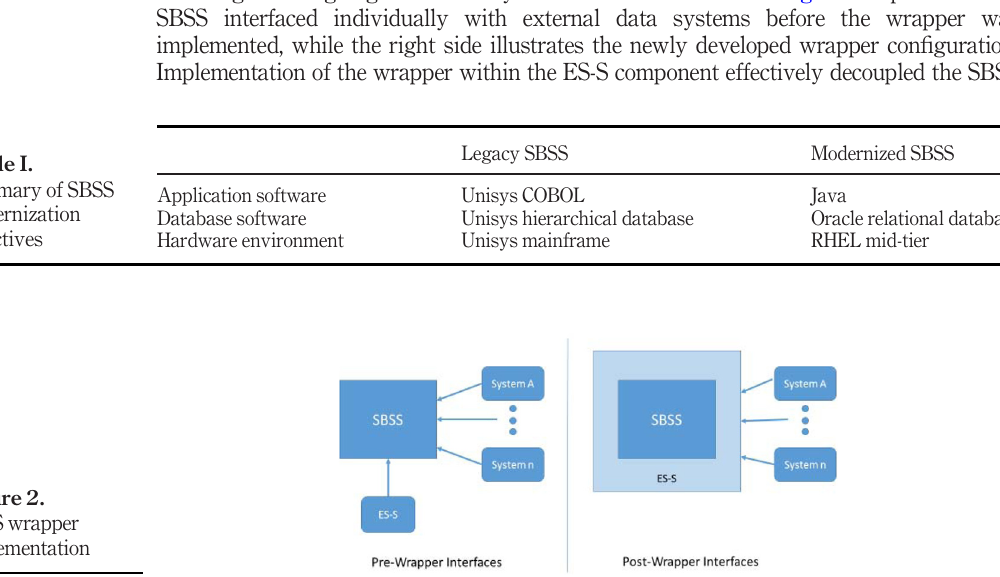
Figure 2. SBSS wrapper